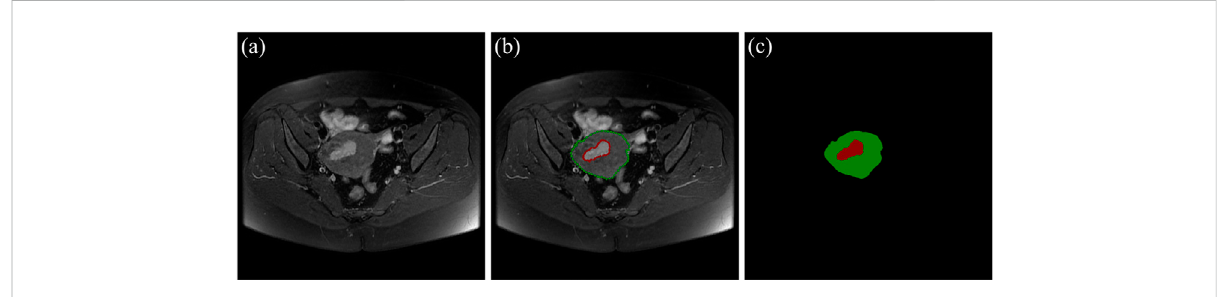
FIGURE 2 (A) TheoriginalMRIimage. (B) TheoriginalMRIimagewithground-truthcontoursoftheuterusandtumor,wheretheredoutlineistheground- truth of the tumor and the green outline is the ground-truth of the uterus. (C) The label image that LabelMe transforms from the ground-truth contours in (B) which is used for DL model training.